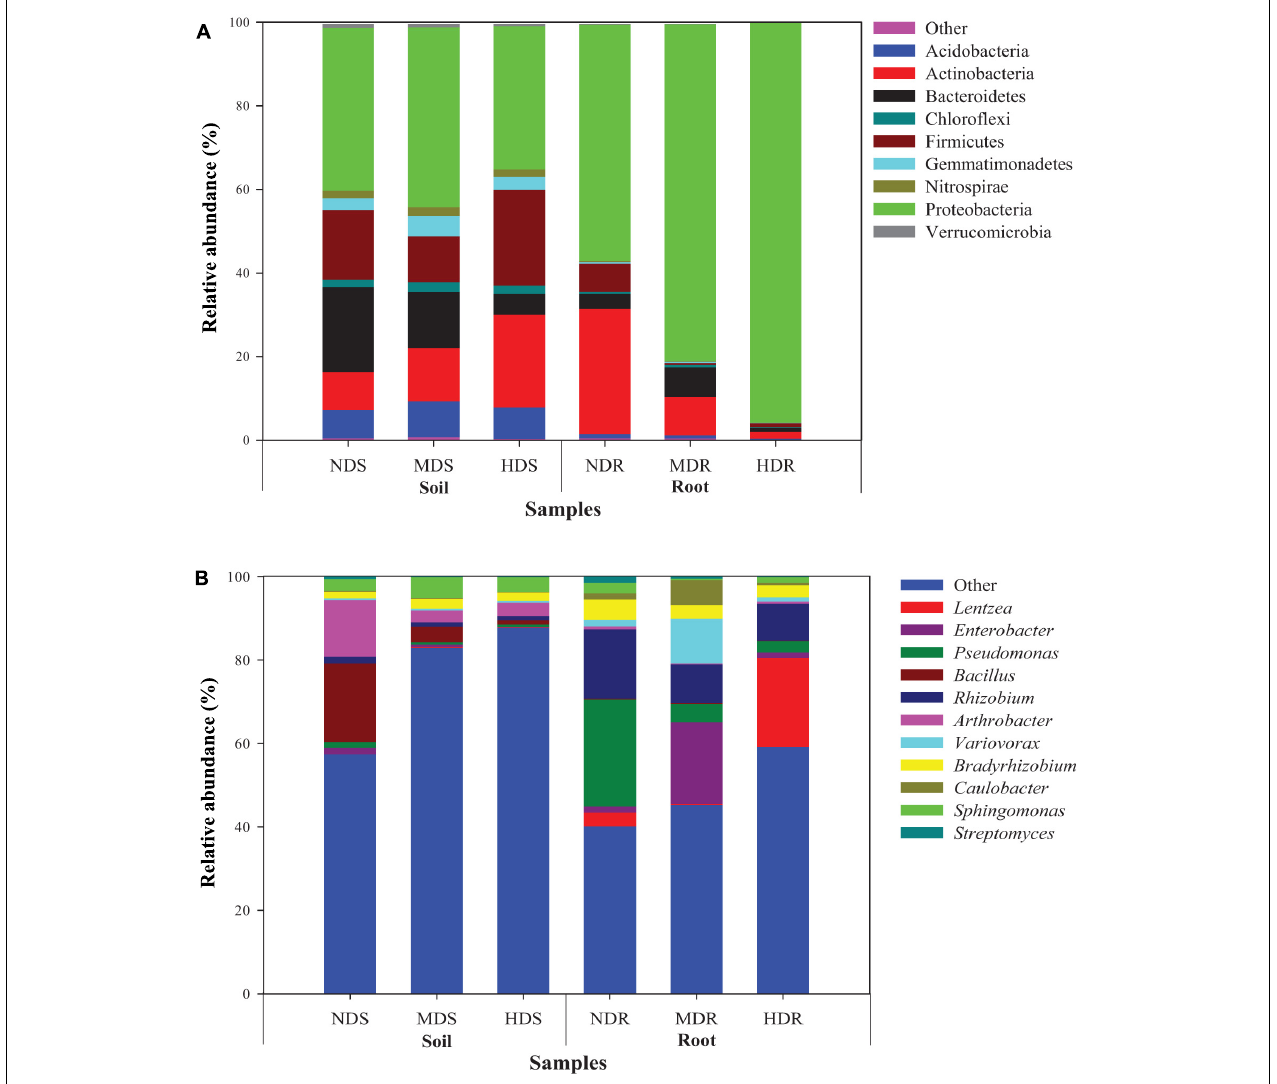
FIGURE 3 | Relative abundance of dominant bacterial taxa ( > 1% of total sequences) in different soil and root samples. (A) Nine phyla and (B) 11 genera. NDS, MDS, and HDS represent the soil samples from the non-diseased, moderately diseased, and highly diseased sites, respectively. NDR, MDR, and HDR represent the plant root samples from the non-diseased, moderately diseased, and highly diseased sites, respectively. Data are expressed as mean ± SD ( n = 3). For each type of samples, different lowercase (soil) or uppercase (root) letters within each group indicate significant differences among the three sampling sites [ p ≤ 0.05; least significant difference (LSD)